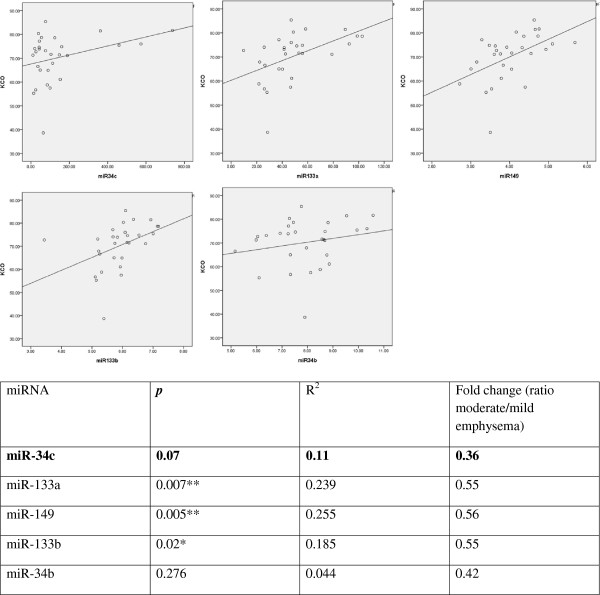
Correlation plots of the five candidate miRNAs and emphysema status. The expression of the differentially expressed microRNAs for the 29 patients and their emphysema status (KCO% predicted corrected for hemoglobin) is shown. The correlation of miR34c expression determined by microarrays in lung tissues to its consequent KCO measurements were not significant (p > 0.05). However this miRNA was chosen for cell line studies as it portrayed siginificant difference in gene expression between patient groups i.e. moderate vs mild emphysema lungs. MiRNA levels ofthe 29 samples are drawn on the X-axis, KCO% predicted on the left Y-axis and microRNA expression on the right Y-axis. * indicates a correlation of significance p < 0.05 and ** indicates a correlation of significance p < 0.01.